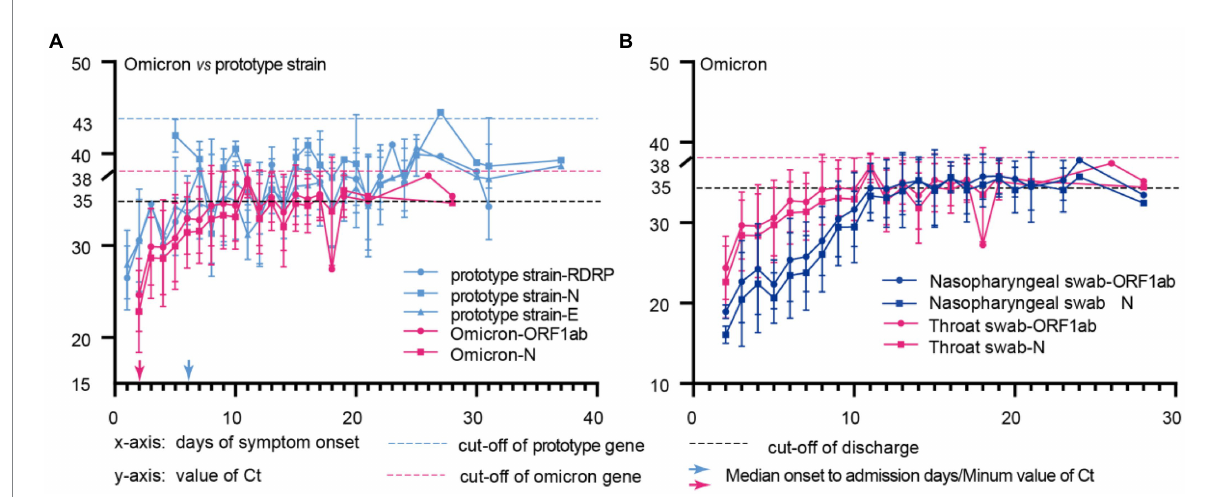
FIGURE 2 Comparison of the dynamic changes in Ct values of Omicron and prototype strain genes in different sample types. (A) , Throat swab from patients with omicron or prototype strain infection; (B) , Throat swabs and Nasopharyngeal swabs of Omicron infected patients; The x-axis represents the time of disease course since symptom onset, and the y-axis shows the Ct values for each feature of prototype strain(blue) and Omicron(red) in different sample types. The blue and red arrows represent the median days from onset to admission for omicron and prototype strain-infected